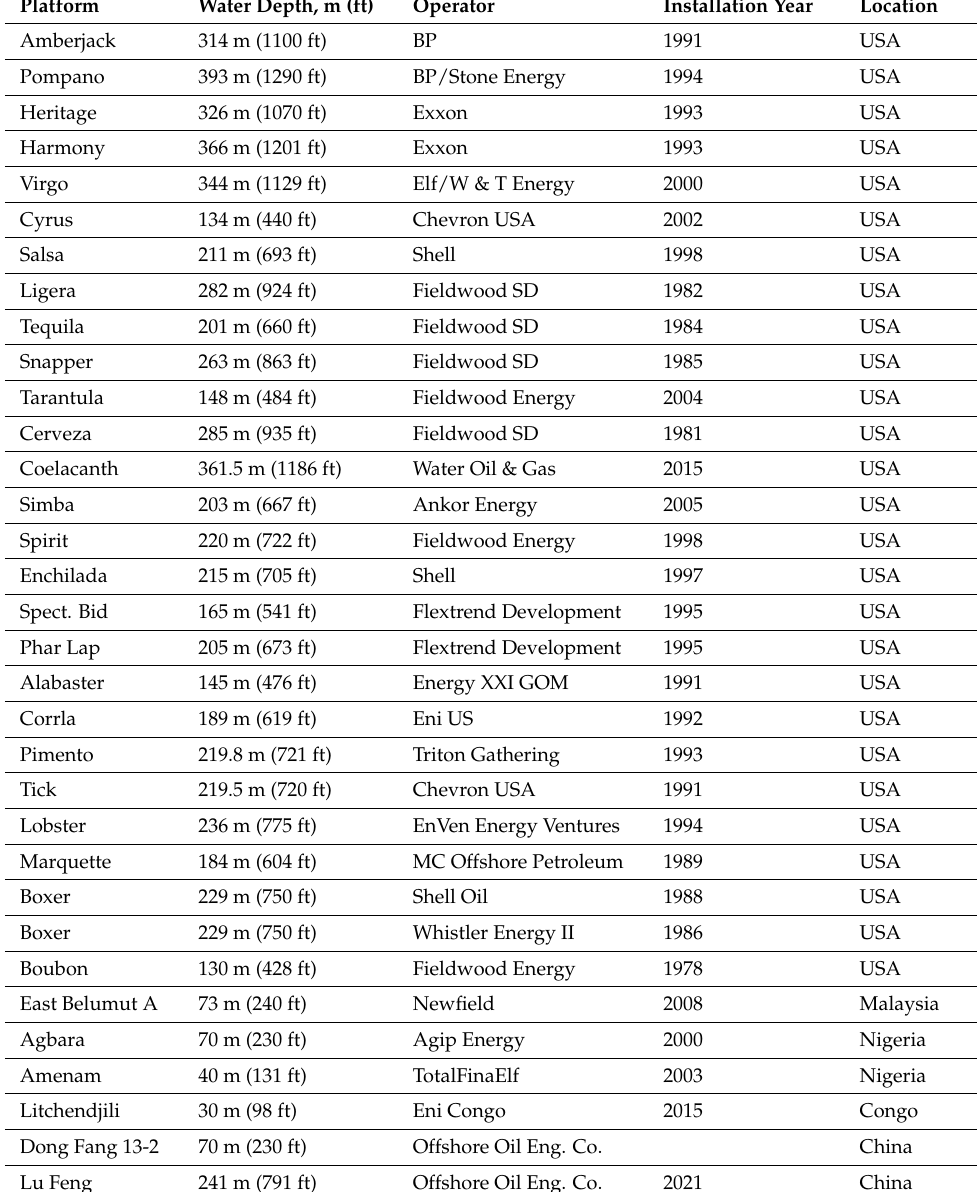
Table 7. List of some jacket platforms